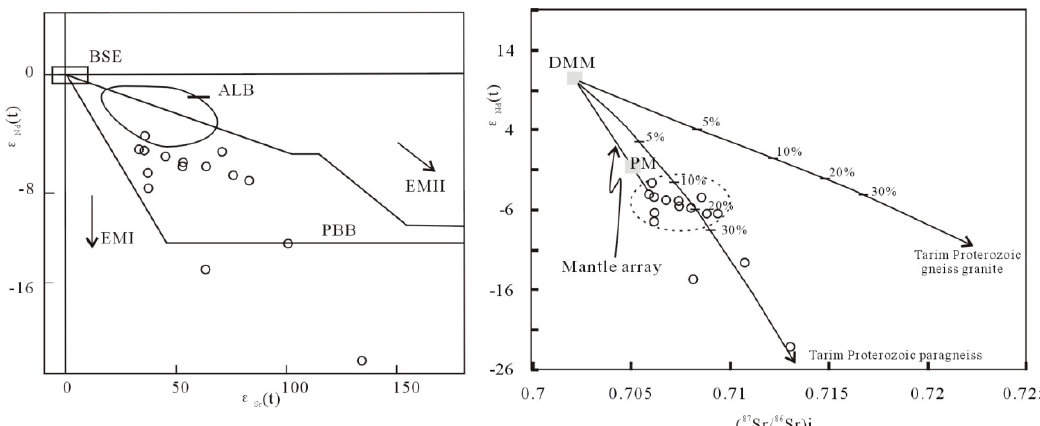
Figure 7. ε Nd( t )– ε Sr( t ) diagram for the Xingdi No.2 mafic-ultramafic rocks and ε Nd (t) versus initial 87 Sr/ 86 Sr plot (t = 752 Ma) and model calculations of Sr-Nd isotopes suggest that the intrusion experienced variable contamination of Tarim Proterozoic gneiss and granite. The isotopic compositions of Nd and Sr for PBB and ALB values are from [42]. Data for depleted mid ocean ridge basalt (MORB) mantle (DMM) are from [41] and Tarim Proterozoic gneissic granite from [43]. BSE: Bulk standard earth, PBB: Paraná basin basalt in Brazil, ALB: Archean lithospheric mantle in western United States, EMI: I-typed enriched mantle, EMII: II-typed enriched mantle.